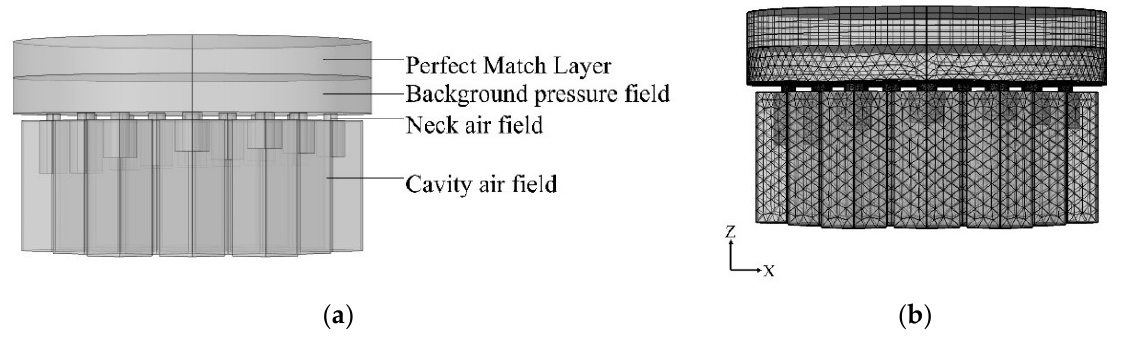
Figure 4. Finite element simulation model. ( a ) Finite element model of the acoustic metamaterial of multiple parallel hexagonal Helmholtz resonators. ( b ) Finite element mesh division of the proposed acoustic metamaterial.